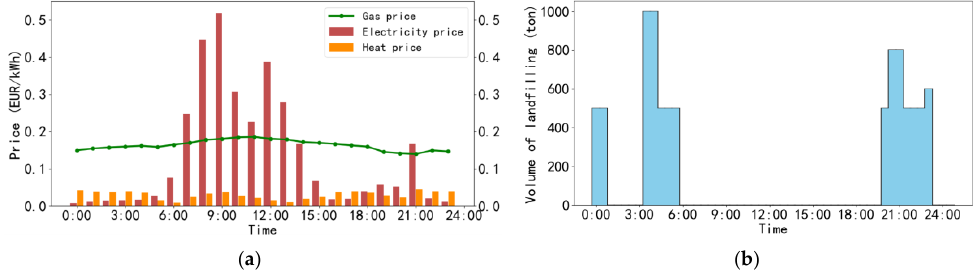
Figure 6. The energy price and waste transportation of a typical day.( a ) Energy price; ( b ) Waste transportation.